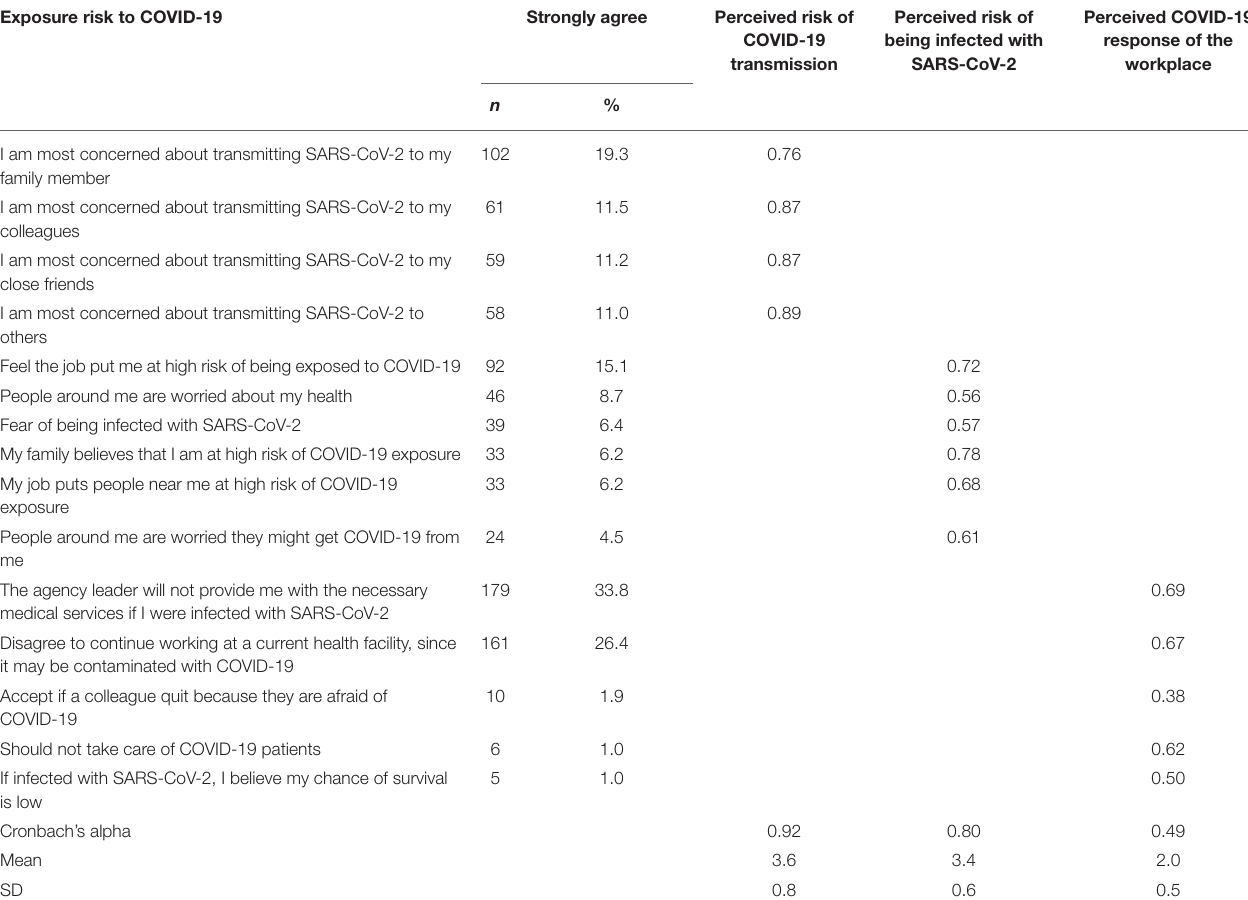
TABLE 2 | Perceived risk of exposure to COVID-19. Exposure risk to COVID-19 Strongly agree Perceived risk of